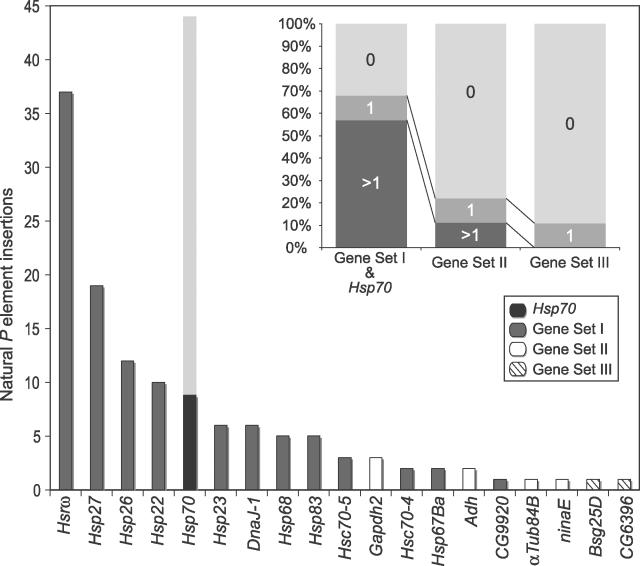
Number of Natural P Element Insertions (161 Total) Distinctive by Population and Location into the “Proximal Promoter Region” of Each of the Screened Genes (Table 1)Genes without any such insertions are not represented in the main figure. These tallies and estimates are conservative in three ways: (1) P elements inserting within 1,000 bp of the transcription start site of Bsg25D and CG6396 are included although they actually insert into neighboring genes (see Figure 4); (2) The tally for Hsp70 excludes non–P elements and those previously discovered (Figure 2), and divides the remaining total (44, light gray bar in background) by five, the Hsp70 copy number for natural populations [17]; and (3) Re-screening of a subset of insertions implies an underestimation of the tally at the 161 P insertion sites (see Results and Figure 7). Inset: frequencies of genes in each Gene Set (I, including Hsp70, II, and III) in which 0, 1, or >1 P elements had inserted.